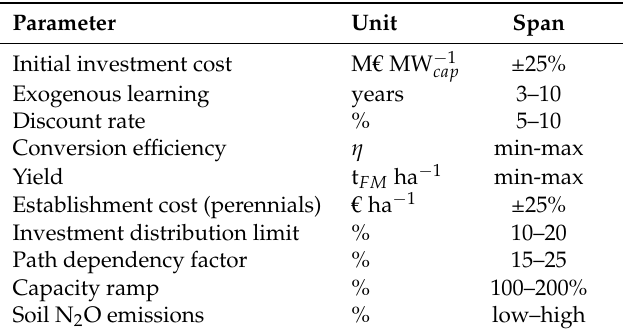
Table 3. Parameters varied in the Monte Carlo sensitivity